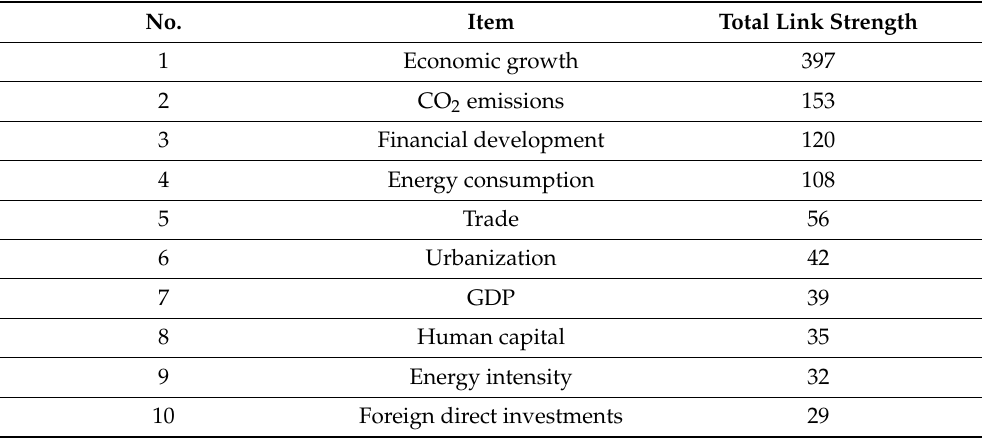
Table 1. The TOP-10 most significant co-occurrence keywords in the general scope of literature concerning the determinants of renewable energy